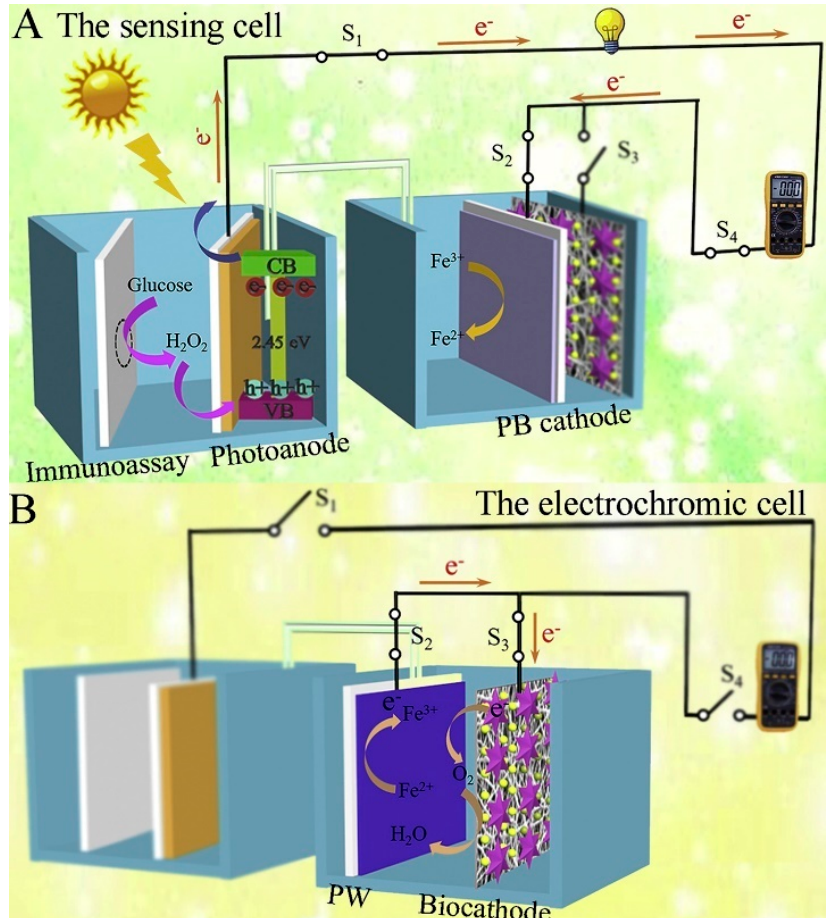
Figure 9. Analytical principle of the salt bridge-connected electrochromic PEC immunosensor with DMM readout: ( A ) The sensing cell; ( B ) The electrochromic cell. Reprinted with permission from ref. [109]. Copyright 2020 Elsevier. Table 3. Analytical performances of various photoelectrochemical immunosensors for the determination of CEA. Nanomaterial